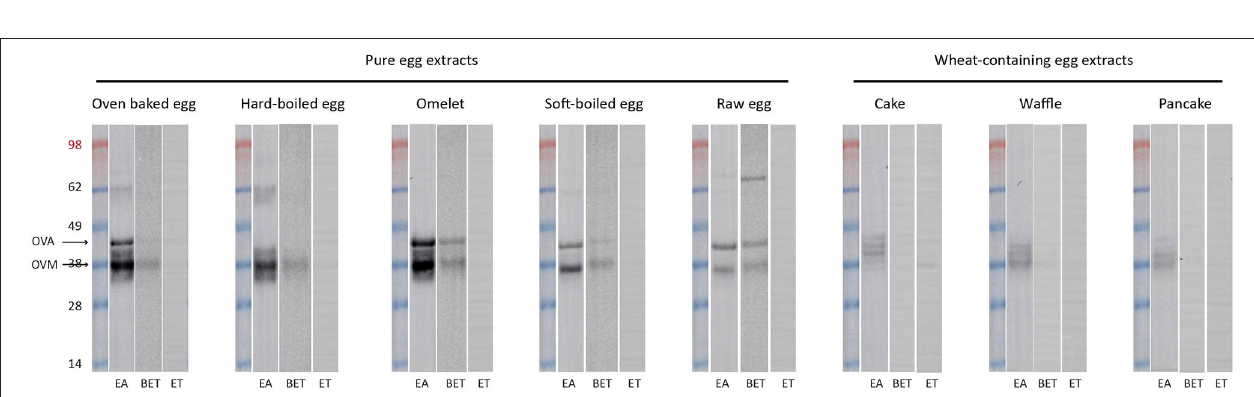
FIGURE 3 | Immunoblots of the pure and processed egg extracts with sera of an egg allergic (EA) child, a baked egg tolerant (BET) child, and at present complete egg tolerant (ET) child who had a grade III reaction toward egg at initial presentation. At the time of the experiment the egg sIgE levels were as followed, for the EA (age: 13m, girl) : IgE egg white 16.30 kUA/L– IgE ovalbumin 12.30 kUA/L– IgE ovomucoid 8.42 kUA/L, for the BET (age: 11 year, boy) : IgE egg white 1.27 kUA/L– IgE ovalbumin 1.36 kUA/L– IgE ovomucoid 0.44 kUA/L and for the ET (age: 3 year, girl): IgE egg white 0.20 kUA/L– IgE ovalbumin 0.20 kUA/L– IgE ovomucoid 0.10 kUA/L. Of note, silver staining was not performed in parallel but presence of the respective proteins was inferred from earlier SDS-PAGE analysis of the egg extracts as indicated in Figure 2